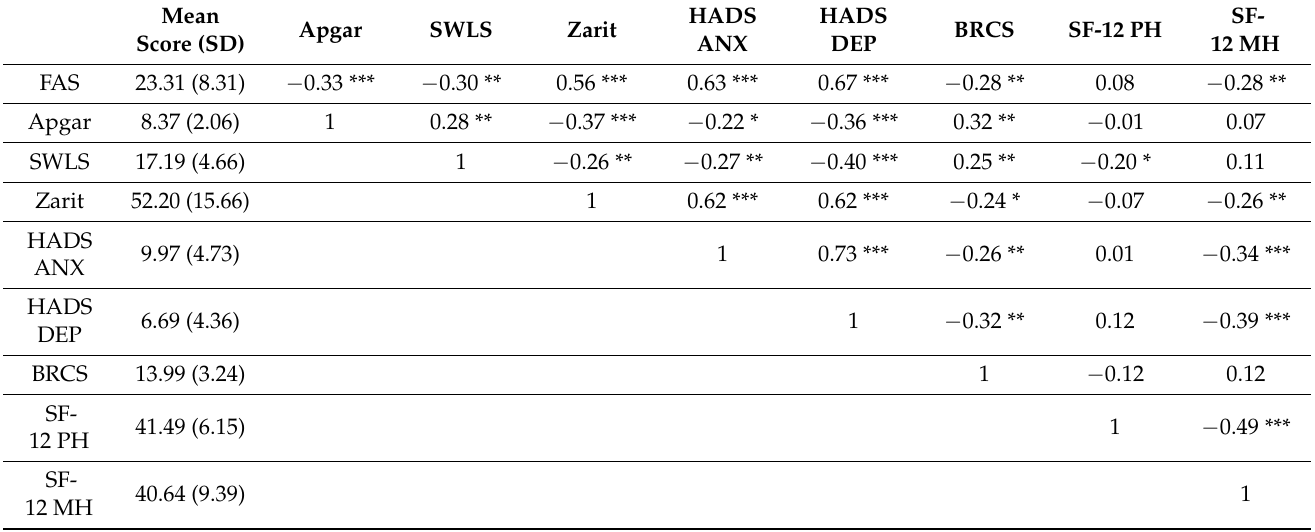
Table 3. Bivariate Pearson correlations between FAS and the variables of family functioning,